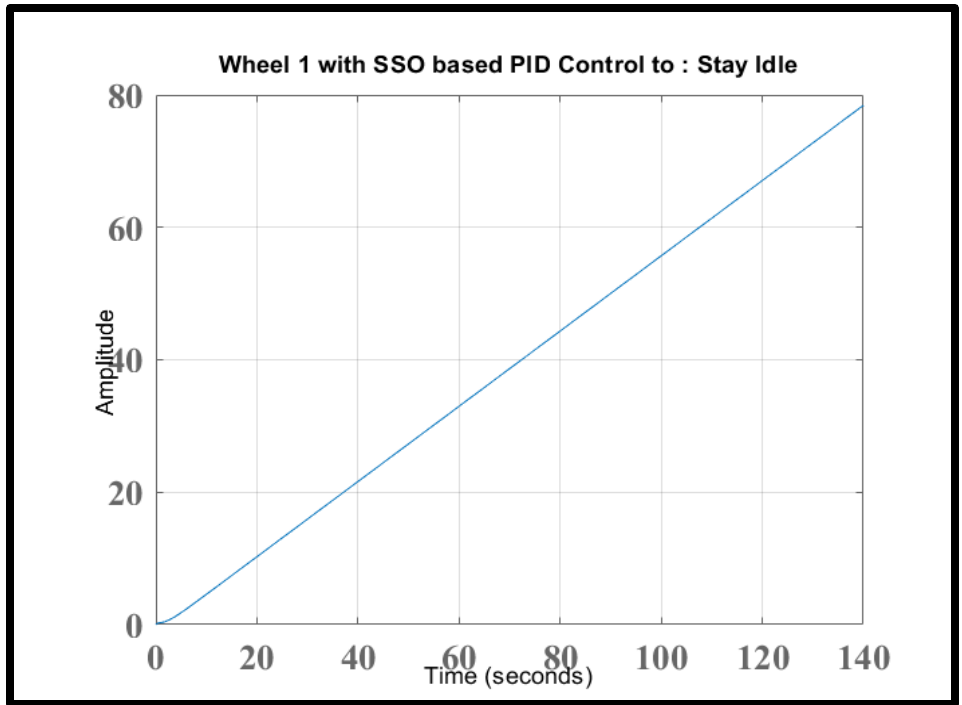
Figure 9. Simulation of wheel 1 when V L = V r .